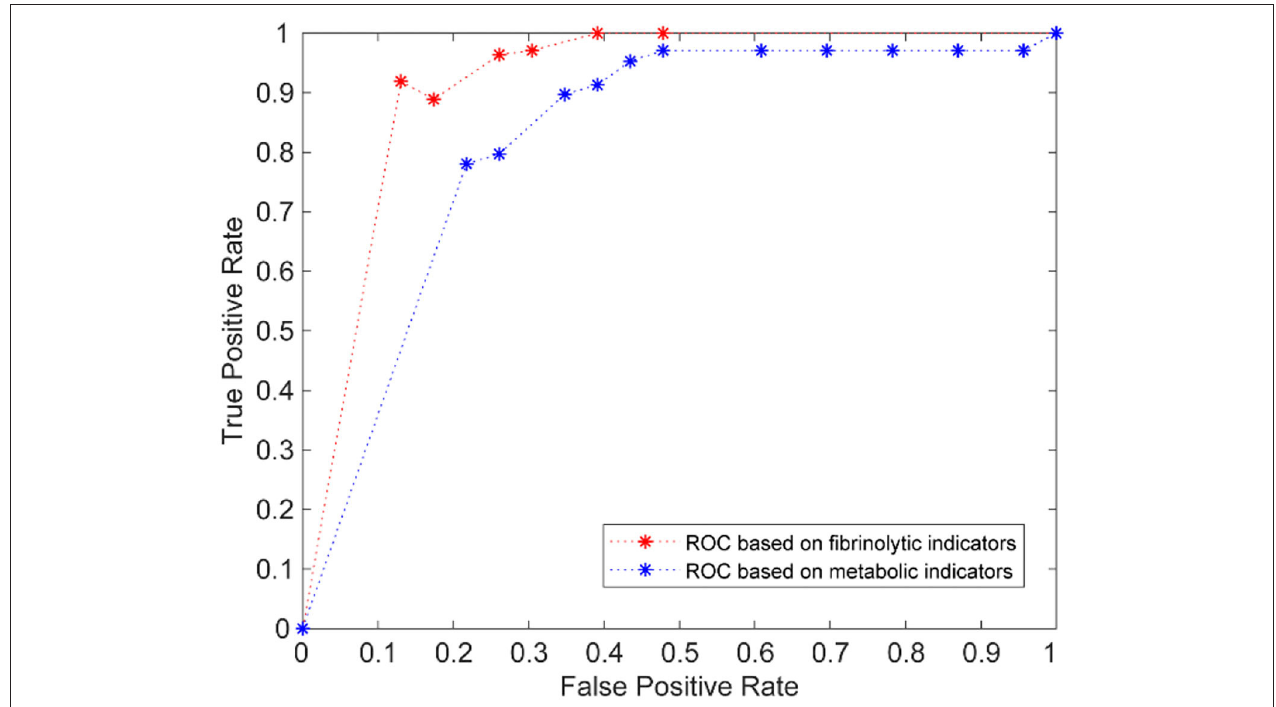
FIGURE 2 | The comparison of ROC curves of SVM based on fibrinolytic indicators and metabolic indicators.